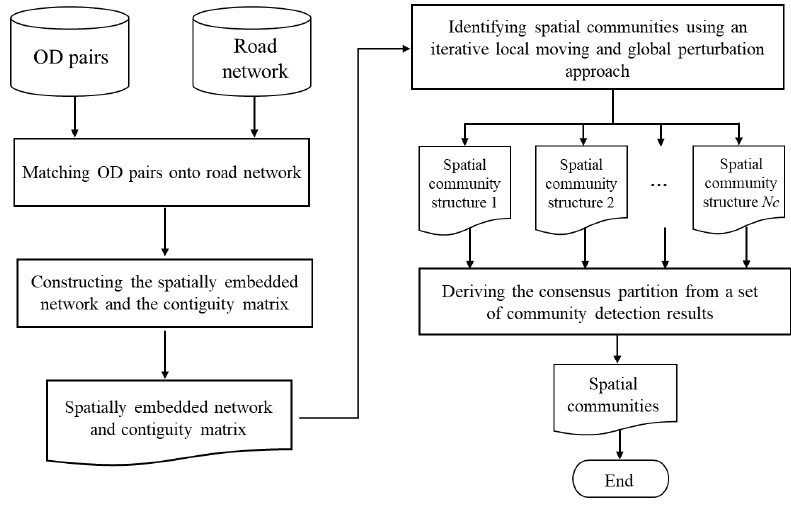
Figure 2. Framework of the proposed method.